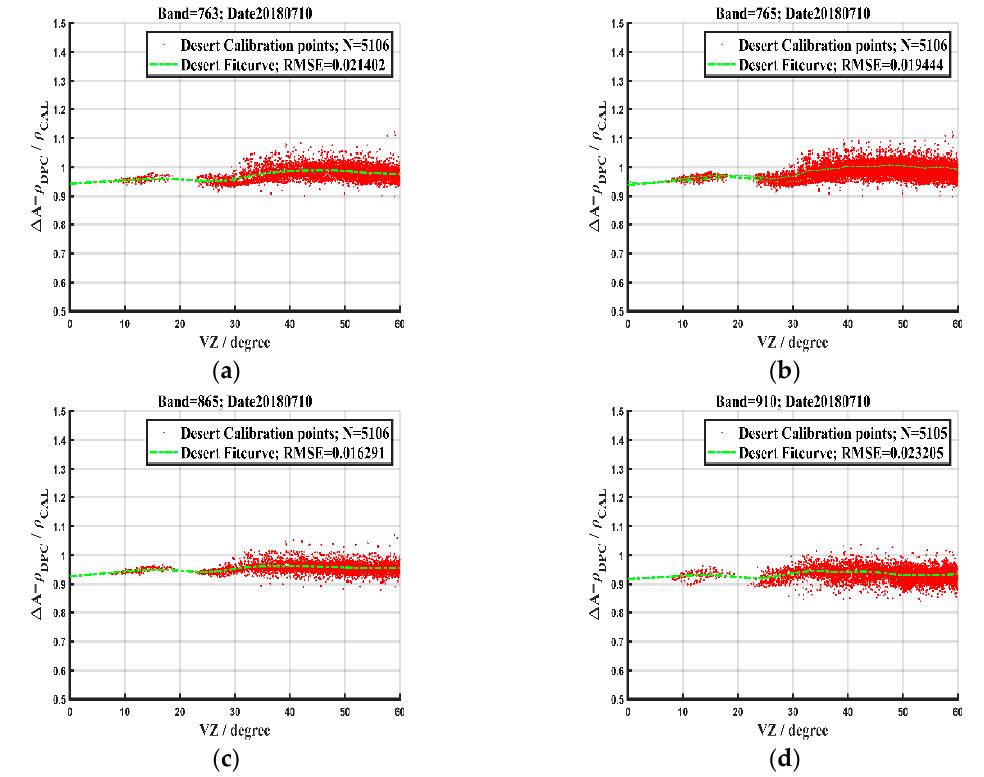
Figure 5. The radiometric deviation calculated over the LNES of the NIR bands for the DPC: ( a ) Band 763; ( b ) Band 765; ( c ) Band 865; ( d ) Band 910.